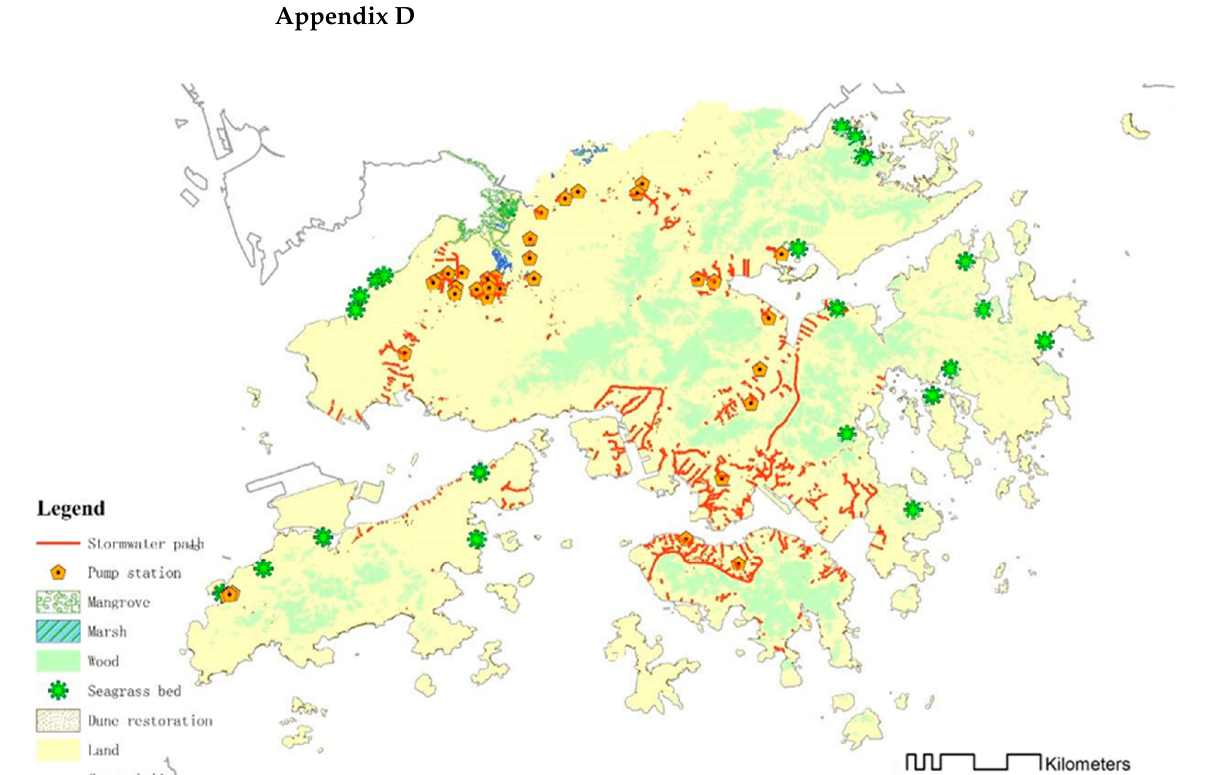
Figure A3. Historical level of tide (meters).